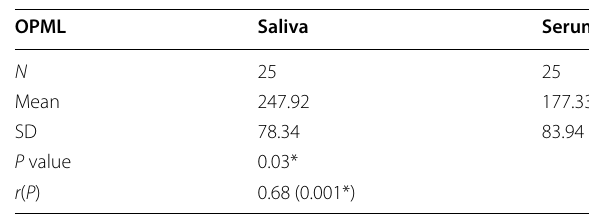
Table 1 Mean and standard deviation of saliva and serum